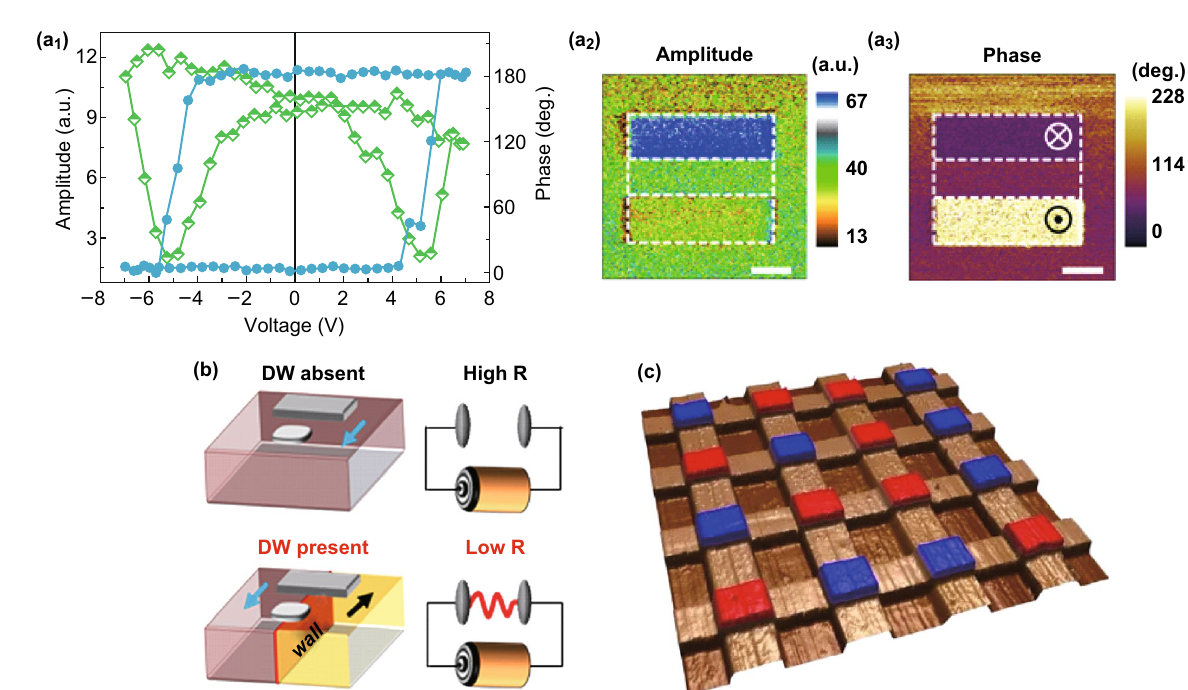
Fig. 6 Application for electric devices. a Ferroelectric switching and stability in BFO films measured in argon. The applied voltages are +5 V and − 5 V voltage. Adapted with permission from Ref. [30]. b A prototype nonvolatile ferroelectric domain wall memory device with a scale below 100 nm. Adapted with permission from Ref. [119]. c Ferroelectric memory device based on photovoltaic effect of BFO. Blue: polarization up, red: polarization down. Adapted with permission from Ref. [18]. (Color figure